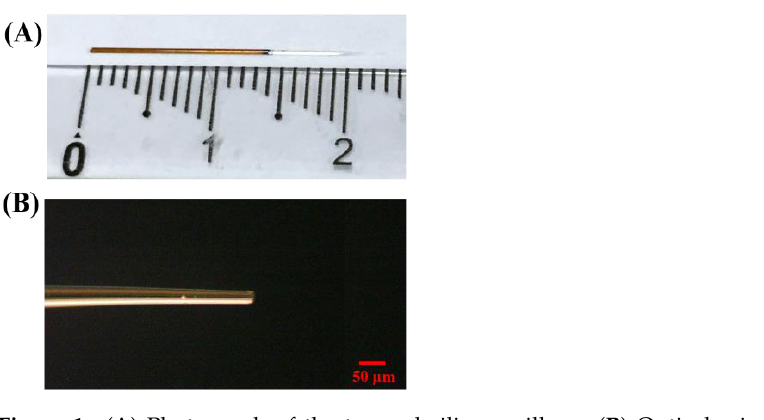
Figure 1. ( A ) Photograph of the tapered silica capillary. ( B ) Optical microscopic image of the gold-coated capillary.